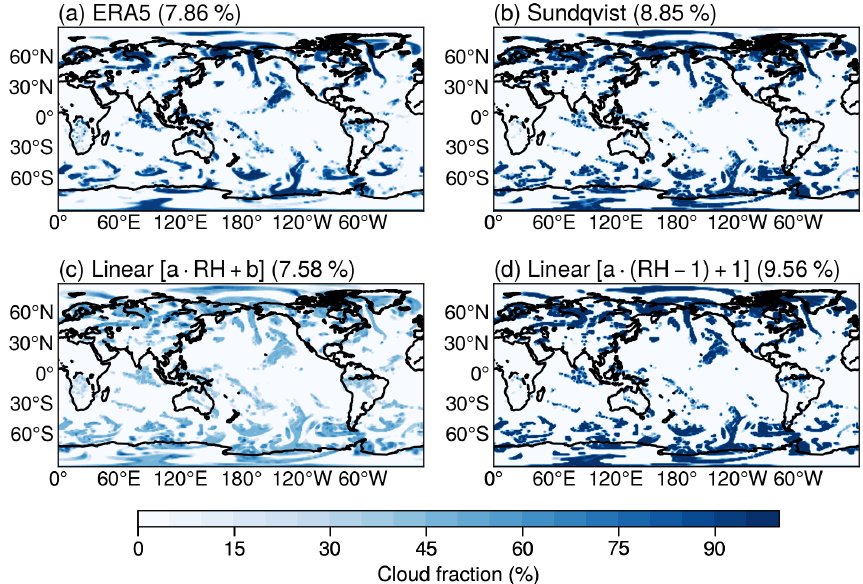
Figure 3. (a) A snapshot of cloud fraction from ERA5 reanalysis at 450hPa at 12:00LT, 1 January 2017. Diagnosed cloud fraction from ERA5 relative humidity field at the same time and level based on the (b) Sundqvist formula and two linear formulas (c) using Eq. (4) and (d) using Eq. (1). Note that Eq. (1) is the form used to determine the large-scale clouds in this study. The global mean cloud fractions are given in the